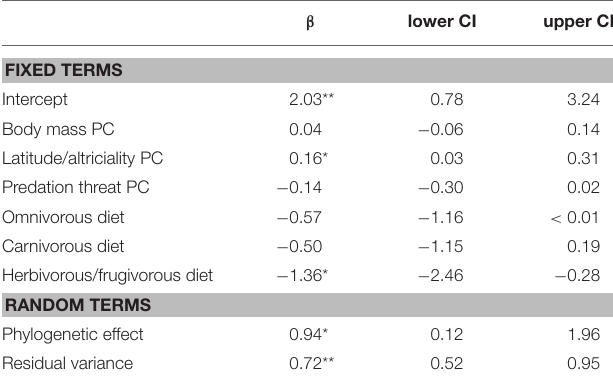
TABLE 2 | Relationship between burrowing class and life-history traits in the